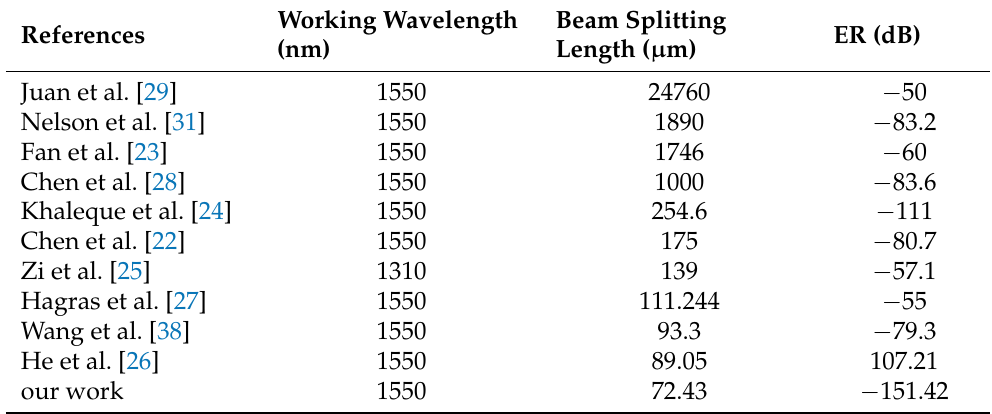
Table 1. Performance comparison between the proposed polarization beam splitter and the previously reported polarization beam